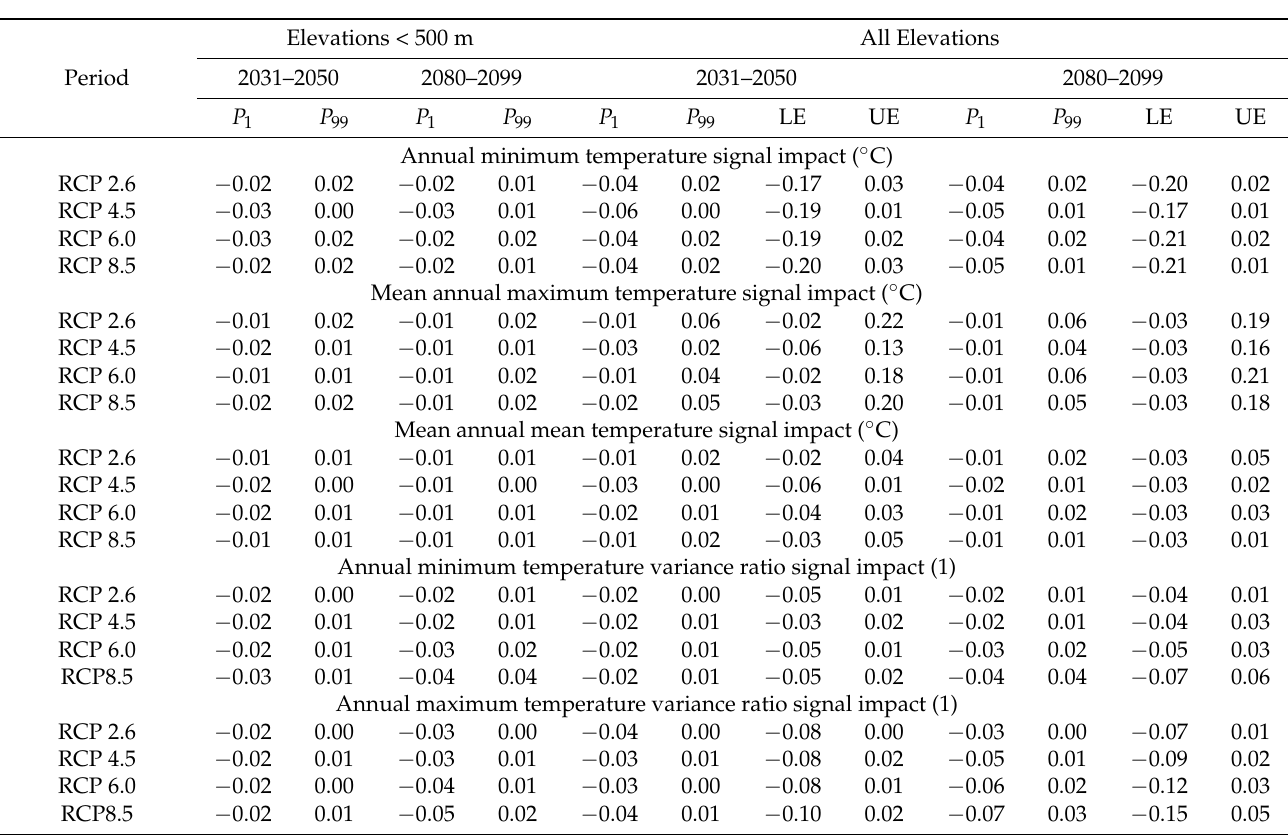
Table A1. Impact on climate change signals of the bias adjustments, expressed for each representative concentration pathway (RCP) as the difference in change signals between the ensemble of six adjusted “SLM RCP” datasets and the ensemble of six original RCP datasets. Change signals were calculated for 2031–2050 and 2080–2099, using a reference period of 1986–2005. Change signals for temperature were calculated as differences between period means, while change signals for temperature variances were calculated as the ratio of variances. Change signals were calculated for each location. Statistics are for all grid locations, mapped across the country. P 1 and P 99 are the first and 99th percentile values, and LE and UE are lower and upper extrema.